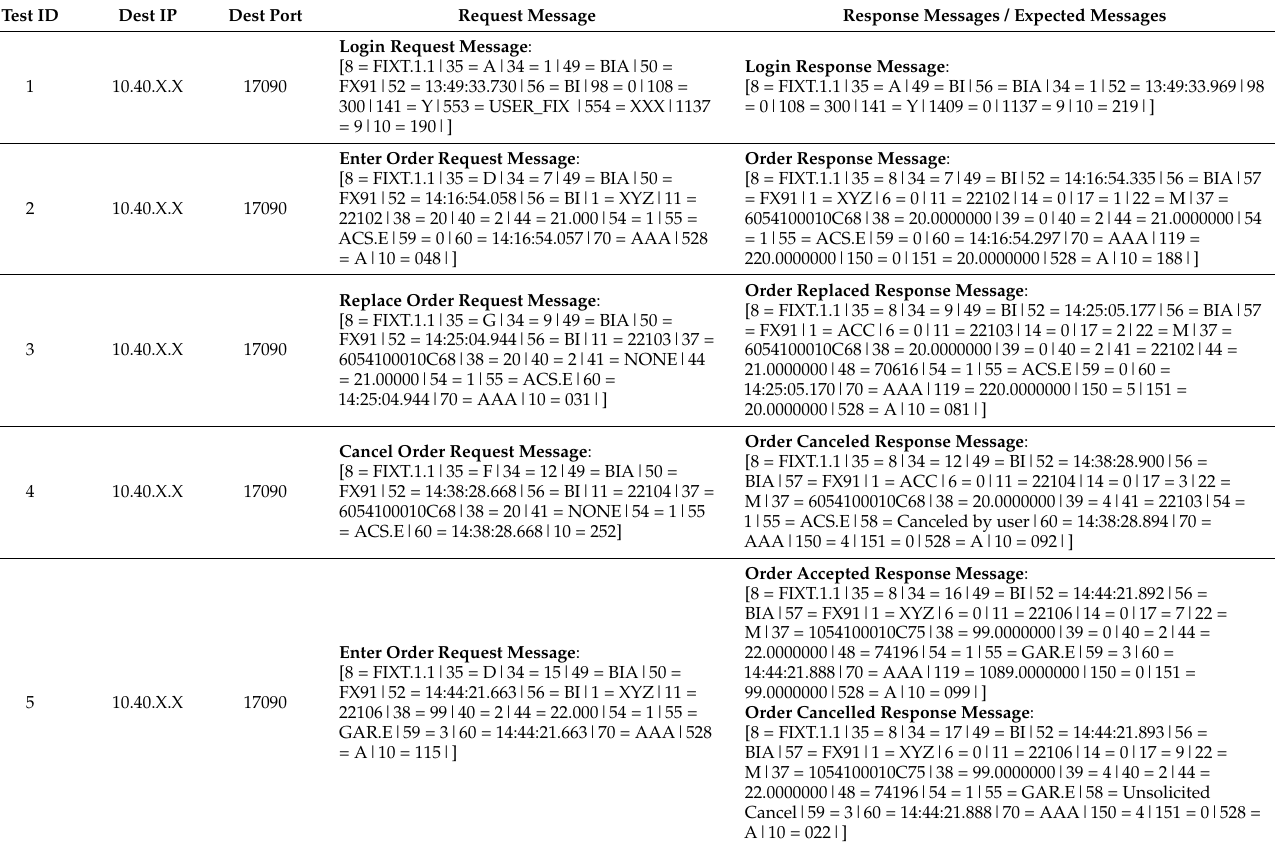
Table 6. Selected FIX-API test cases extracted from